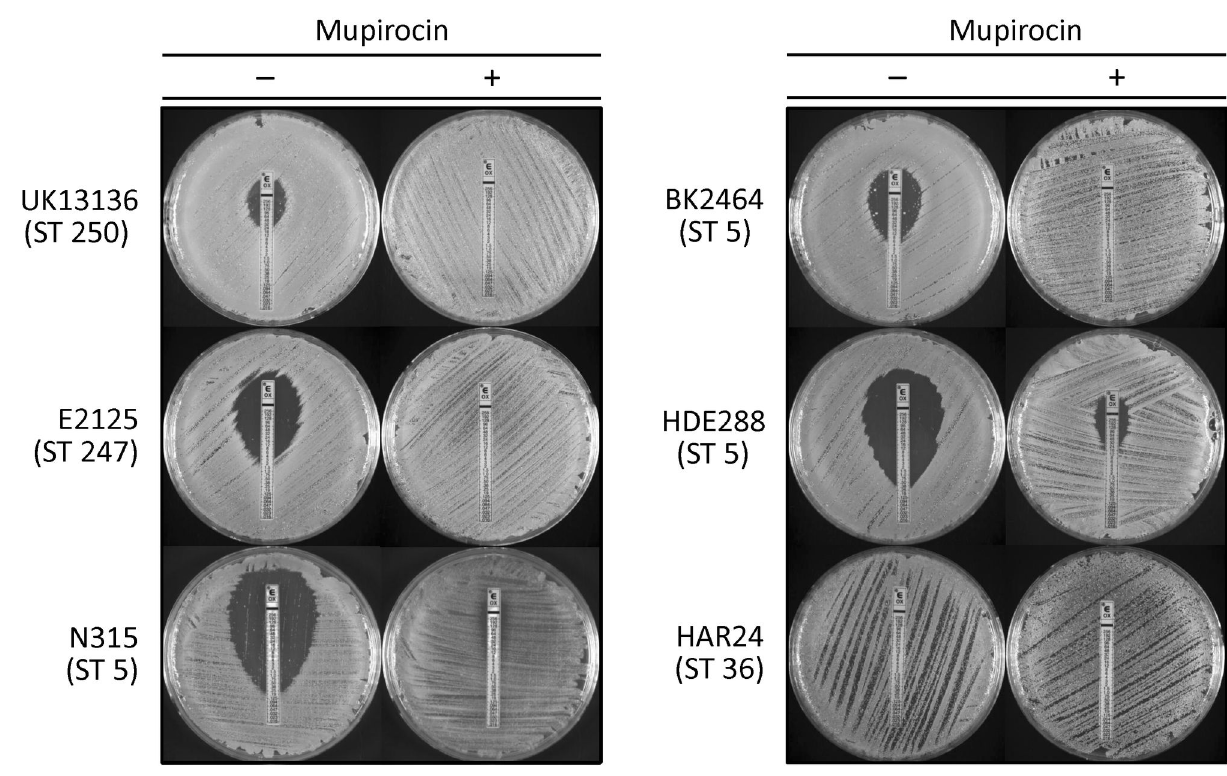
Figure 4. Conversion of the heterogeneous oxacillin resistance phenotypes to homogeneous and high level resistance – in clinical MRSA isolates representing major MRSA clones. Etests for oxacillin resistance were done with or without induction by a sub-MIC concentration (0.03 µg/ml) of mupirocin added to the agar medium.